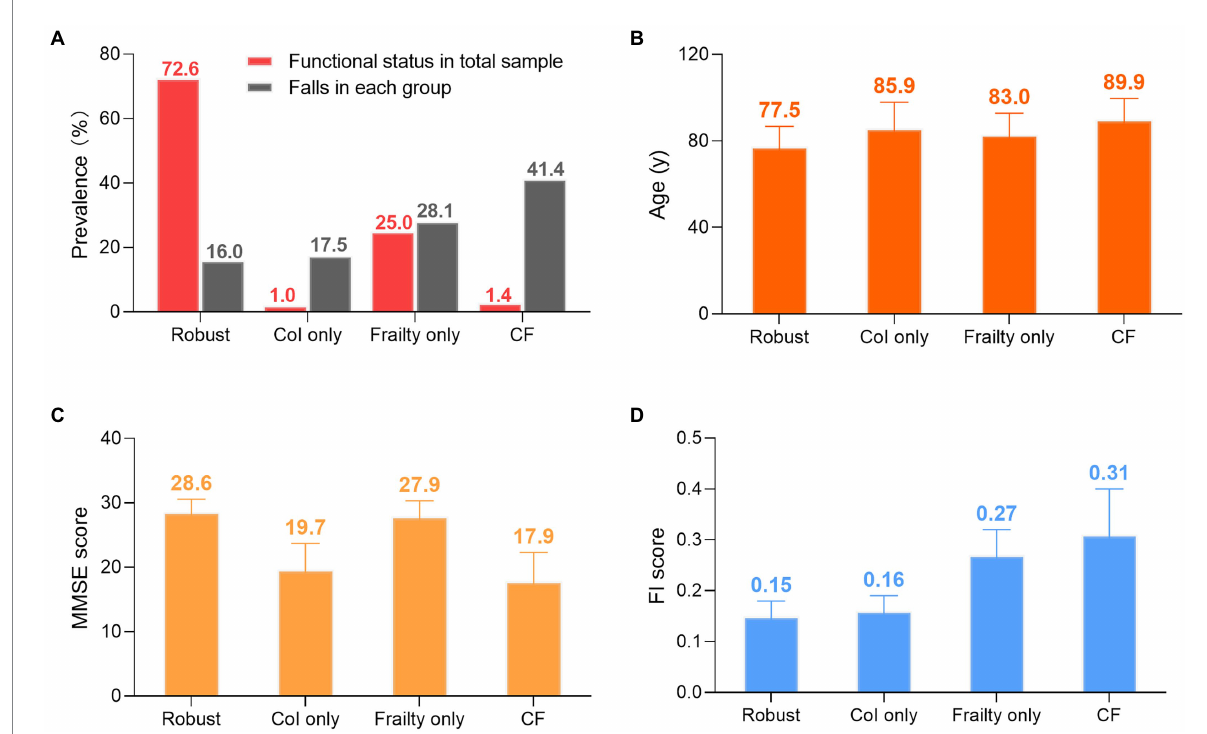
FIGURE 2 Groups differences. (A) Prevalence of functional statuses and falls. Red column represents number of specific status divided by 4,067. Gray column represents number of fallers in each group devided by the group’s total number. (B) Age: mean ± SD. (C) MMSE score: mean ± SD. (D) FI score: mean ± SD Col: cognitive impairment. CF : cognitive fraity. MMSE: mini-mental state examination. FI: fraity index. SD: standard deviation.